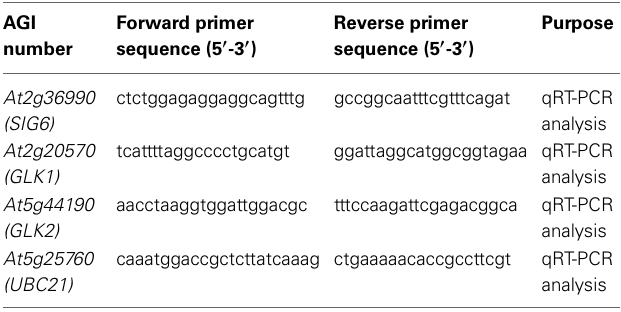
Table 1 | Sequence of primers used in this study.